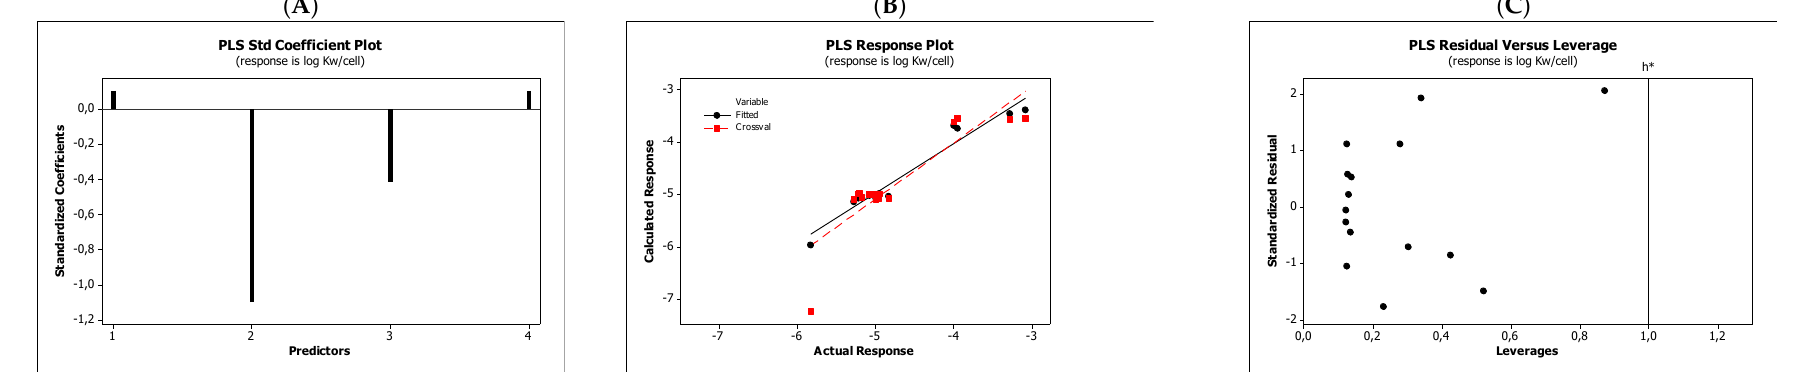
Figure 7. Standardized coefficients ( A ), the correlation between actual and predicted log K w/cell parameters ( B ), and the Williams plots ( C ) of Equation (6).